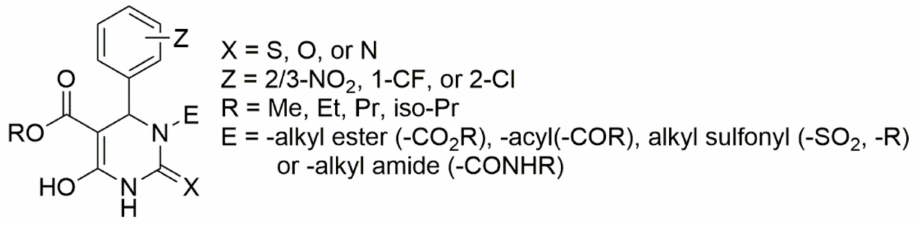
Figure 4. Generalized structure for antihypertensive DHPMs.